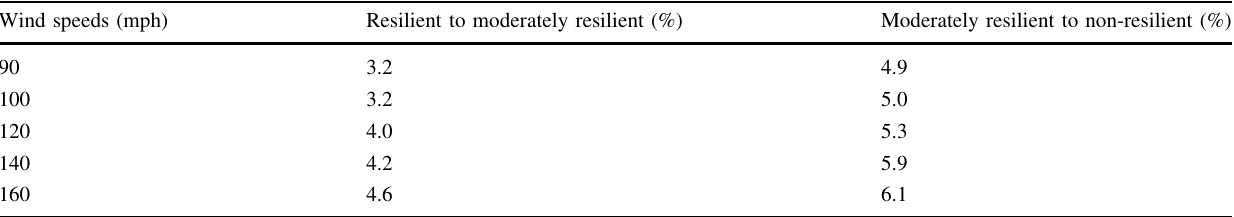
Table 4 Percentage of resilience condition changes in utility poles relative to wind speed Wind speeds